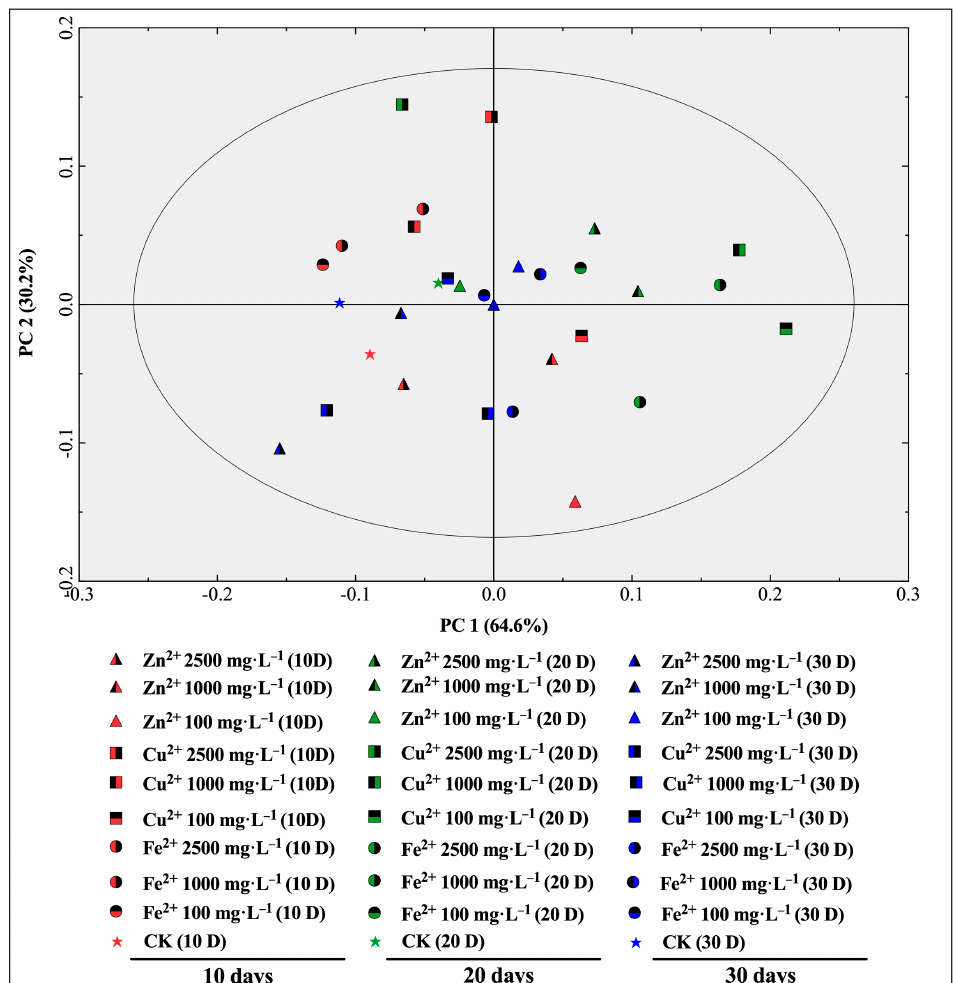
Figure 4. Scores scatter plot of the characteristic absorption peaks in E. sagittatum leaves subjected to FT-IR under the OPLS-DA model.